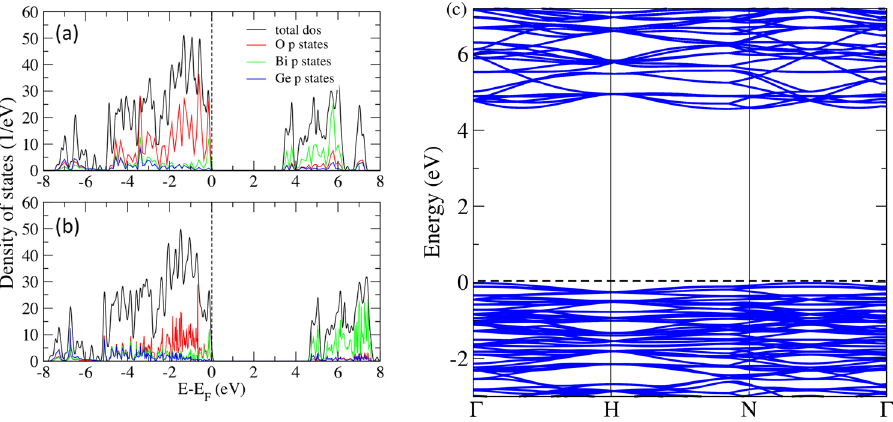
Figure 2. Total and partial density of states BGO calculated using ( a ) DFT-GGA ( b ) DFT-PBE0 and ( c ) band structure of pristine BGO calculated with